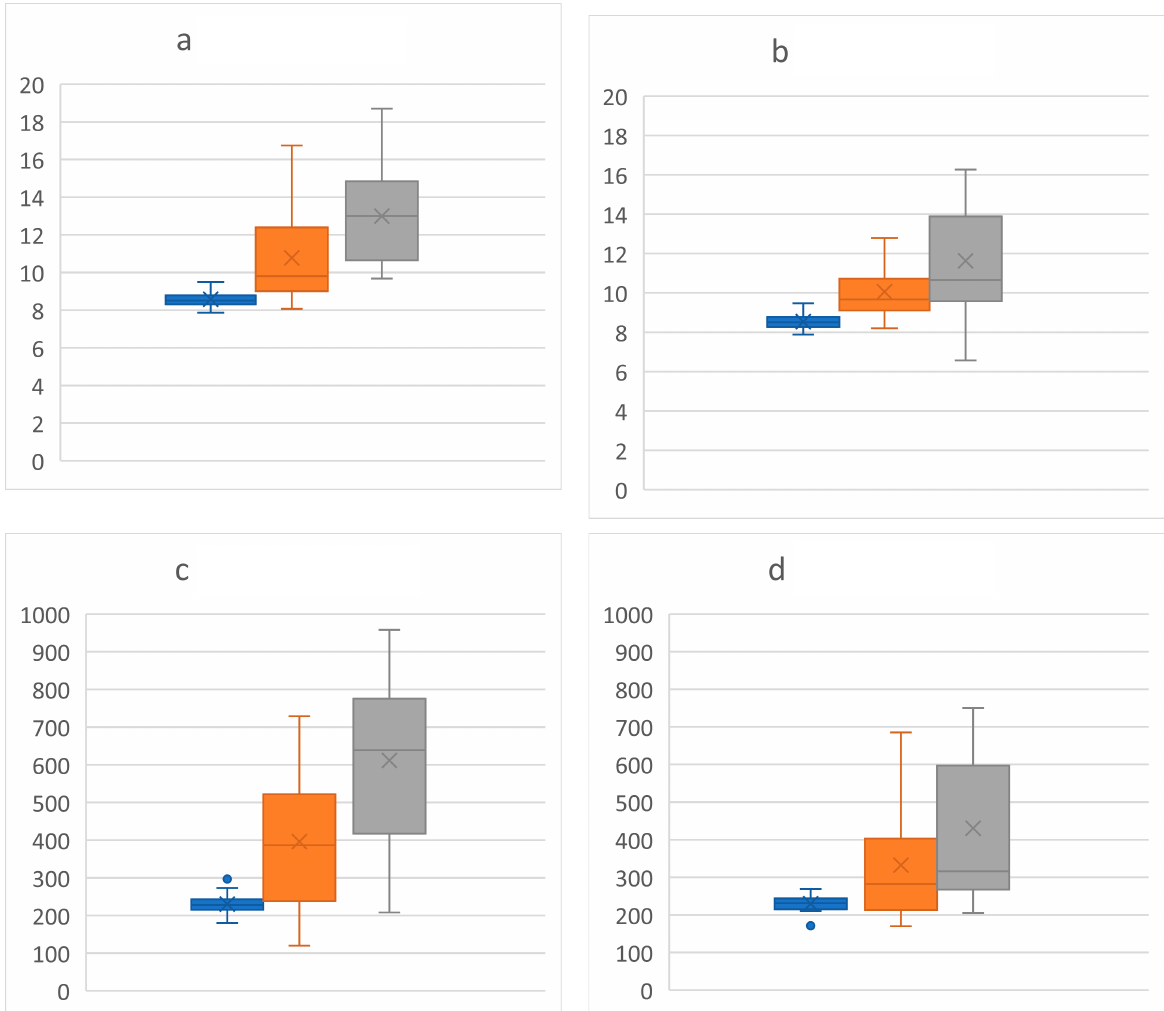
Figure 2. Box plots comparing the macular volume (MV) of the RE ( a ), the LE ( b ), the central macular thickness (CMT) of the RE ( c ) and the LE ( d ) between groups. The measurements are expressed in µm 3 (y axis) for the MV and µm (y axis) for the CMT. Blue—HC, Orange—group A, and Grey—group B.